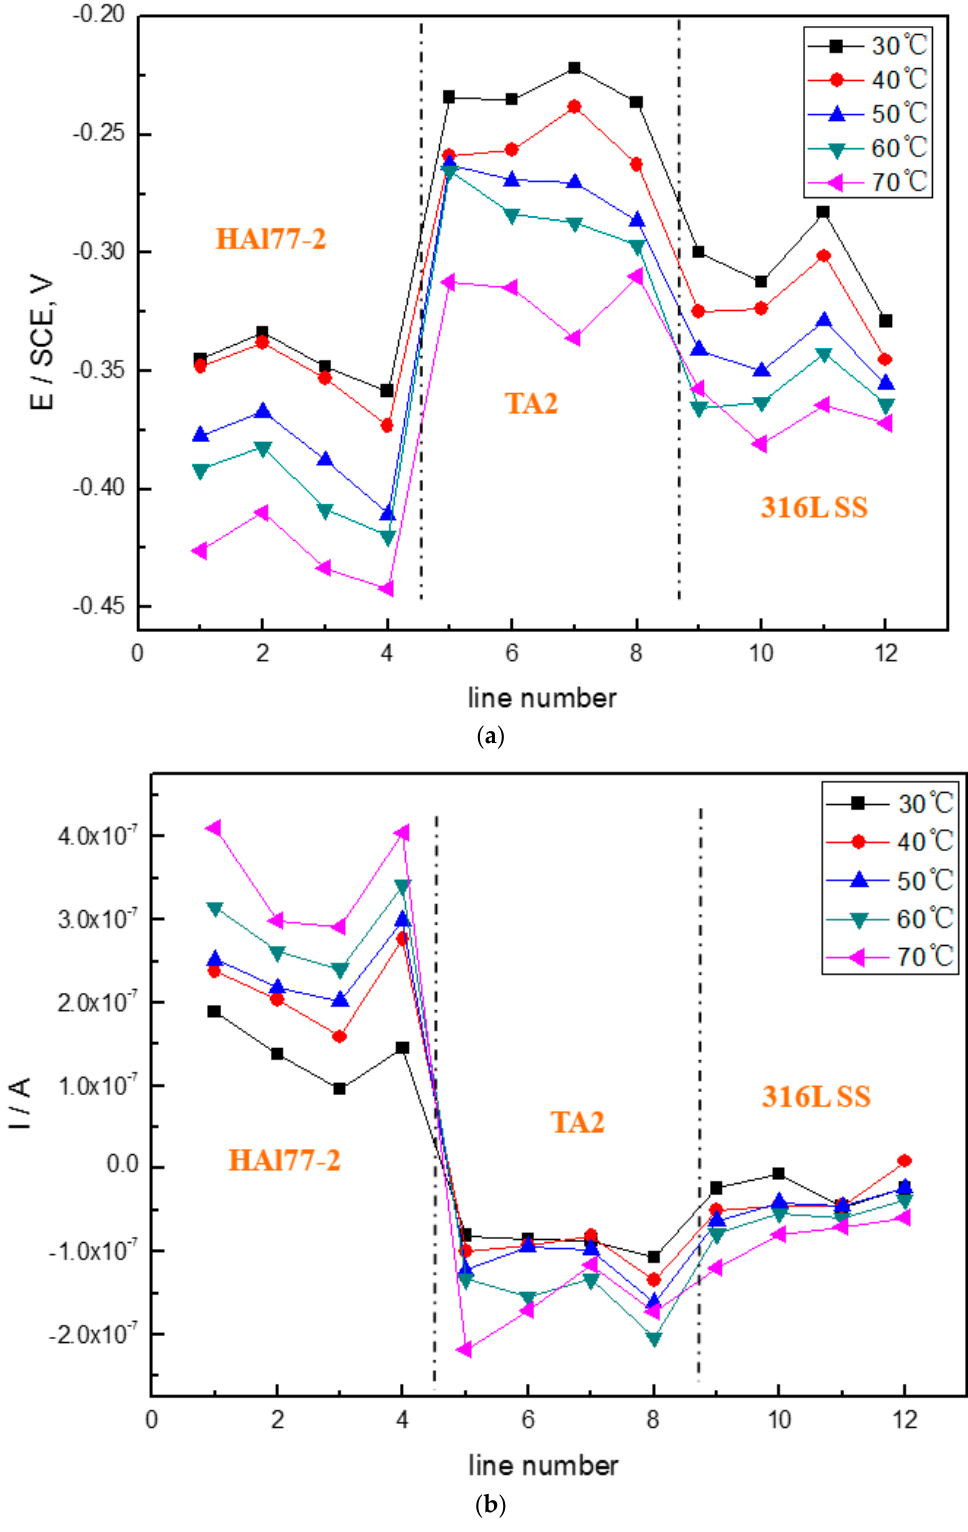
Figure 10. ( a ) Average potential and ( b ) current–density distributions of each WBE2 microelectrode line after being short-circuited for 12 h in artificial seawater at different temperatures.